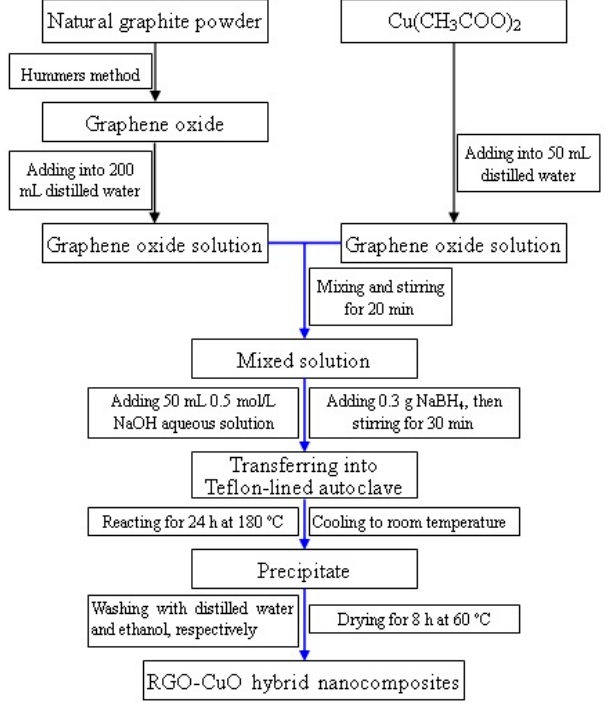
Figure 7. Preparation process of RGO–CuO hybrid nanocomposites.